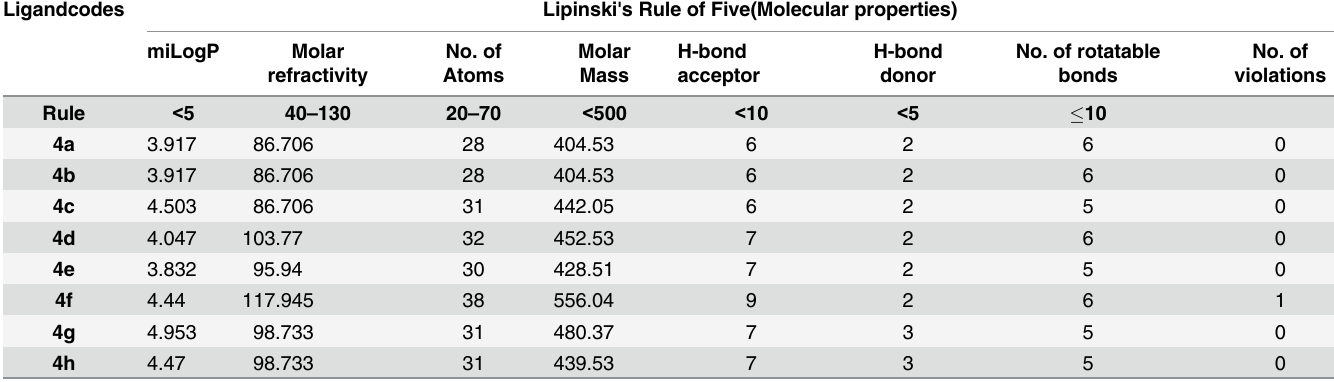
Table 4. Lipinski ’ s Rule of Five screening data for penicillin derivatives (4a-h). Ligandcodes Lipinski's Rule of Five(Molecular properties)